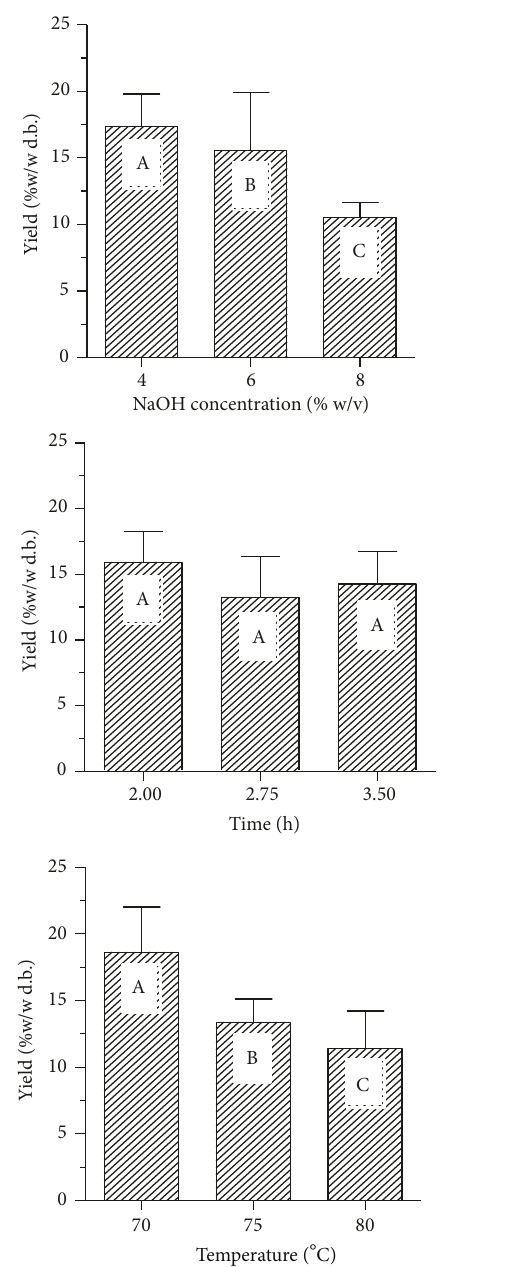
Figure 1: Effects of alkali treatment on yield of carrageenan extracted from H. bryoides (means with the same letter are not significantly different ( 𝛼 = 0.05)).